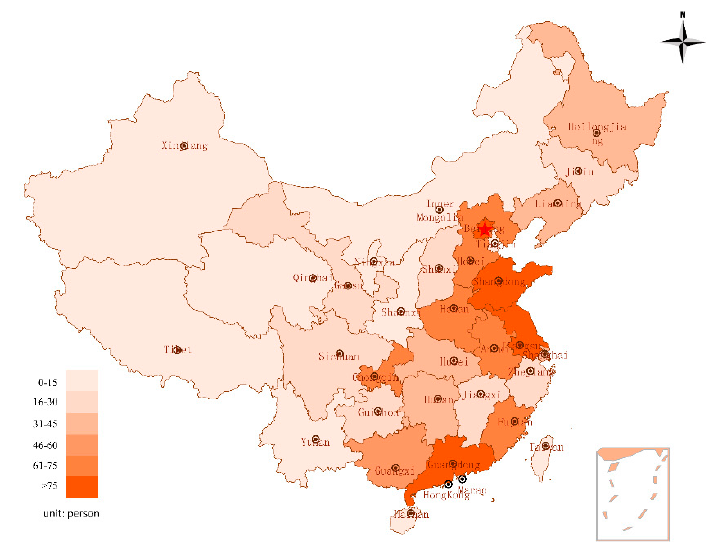
Figure 2. Distribution of participants’ region of residence.